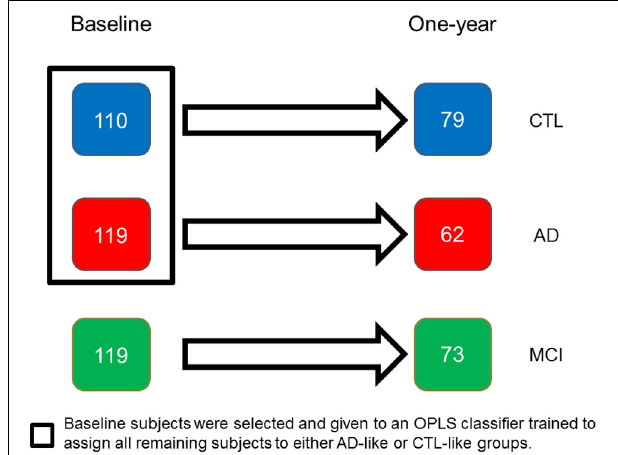
FIGURE 1 | AddNeuroMed longitudinal population: at baseline 348 individuals were assessed using cognitive and MRI methods, with 214 individuals subsequently followed longitudinally. AD, Alzheimer disease; MCI, mild cognitive impairment; CTL, healthy